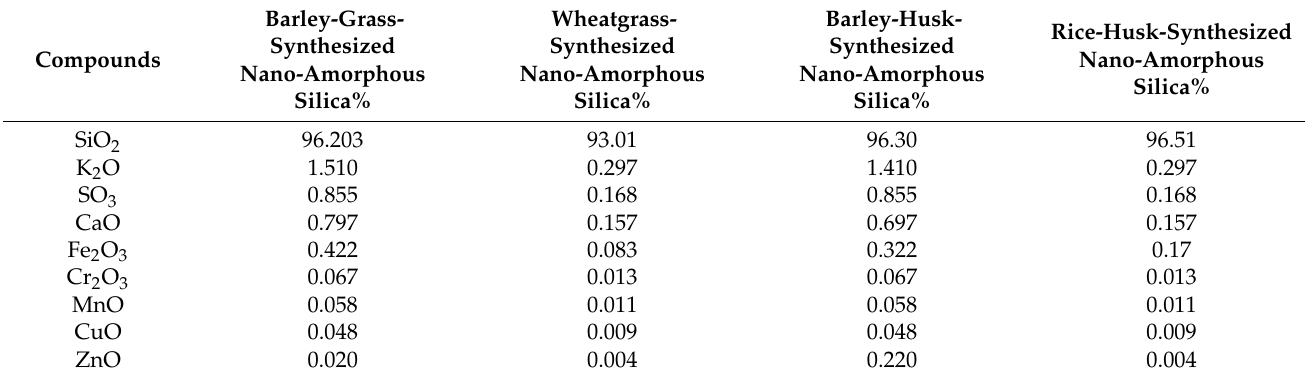
Table 2. XRF compositions of nanoparticles from different